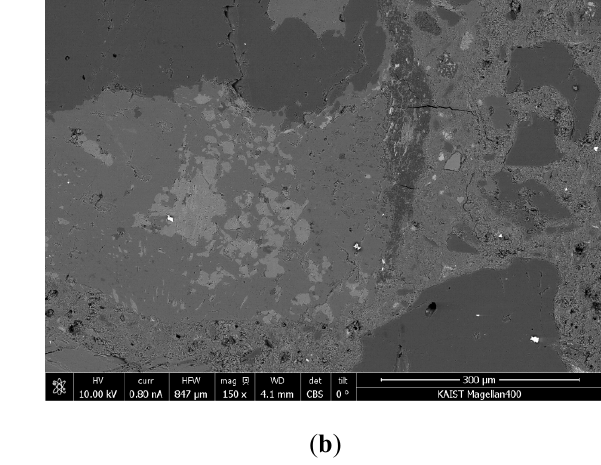
Figure 2. Cycles of freezing and thawing damage of concrete.